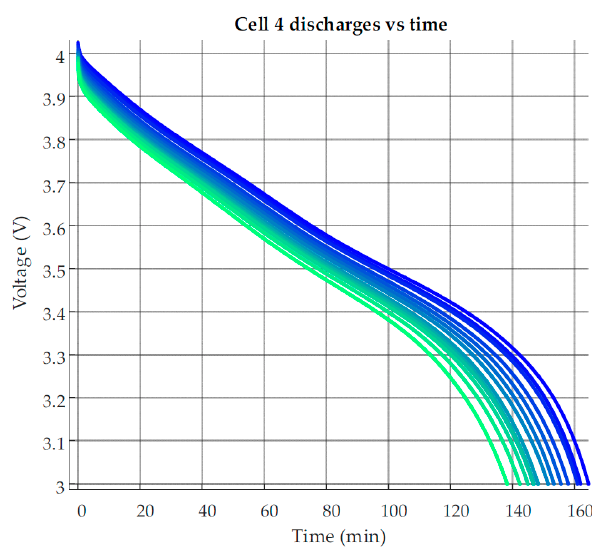
Figure 6. Voltage vs. time curves evolution with aging for cell